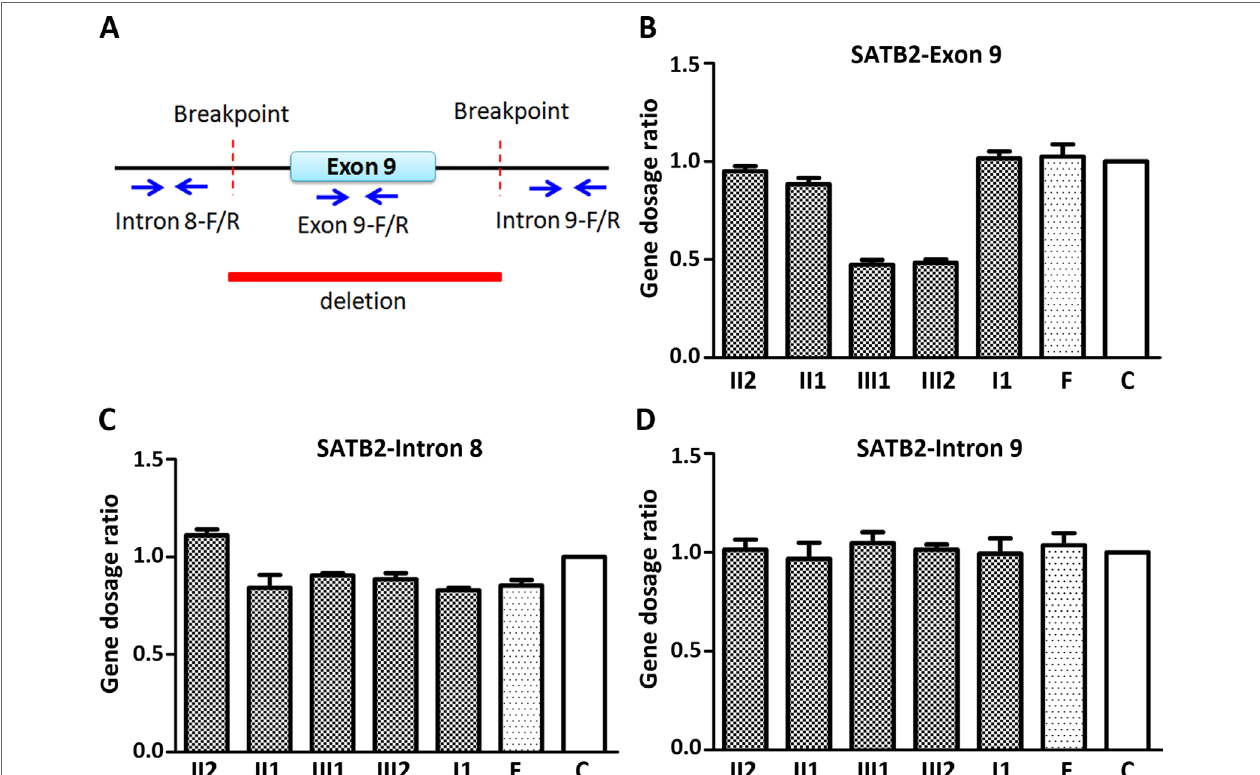
FIGURE 2 | Quantitative PCR (qPCR) of family members using the peripheral blood-derived genomic DNA. (A) Schematic diagram of location of qPCR primers. Blue arrows refer to qPCR primers; (B) Comparison of gene dosage ratios for the family members using the SATB2-exon 9 primers; (C) Comparison of gene dosage ratios for the family members using the SATB2-intron 8 primers; (D) Comparison of gene dosage ratios for the family members using the SATB2-intron 9 primers. F, normal female; C, control (normal